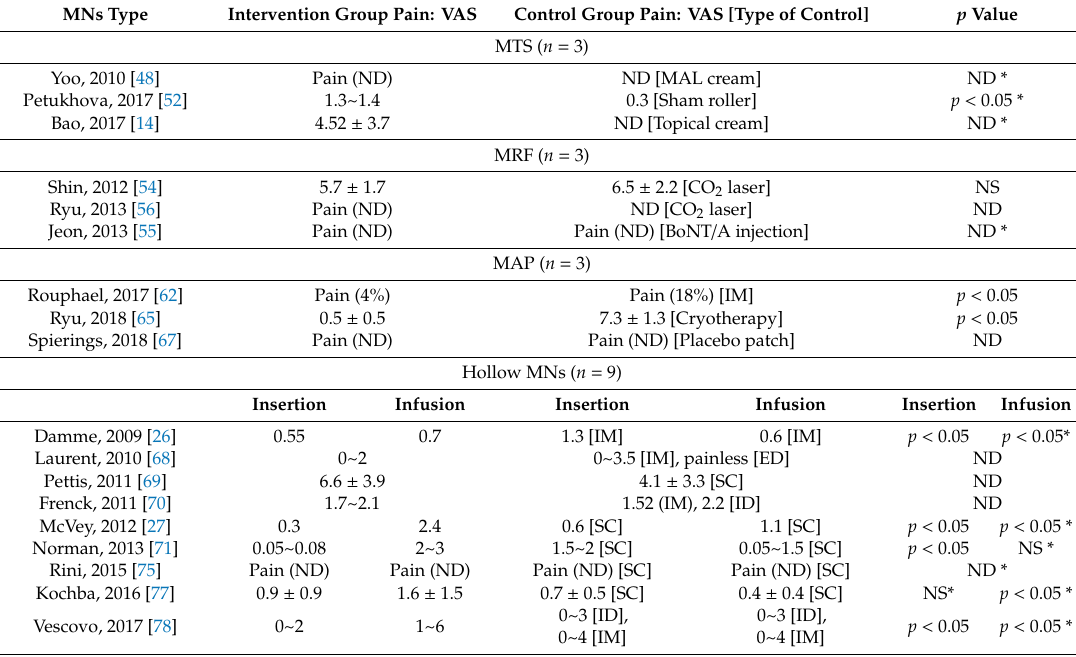
Table 2. Intervention-induced pain of the included